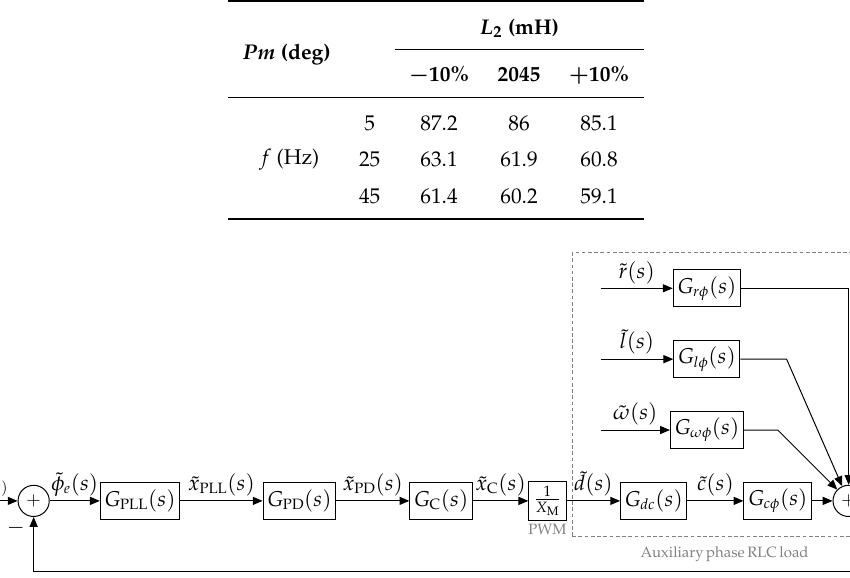
Table 4. Phase margin at different parameters of the system.